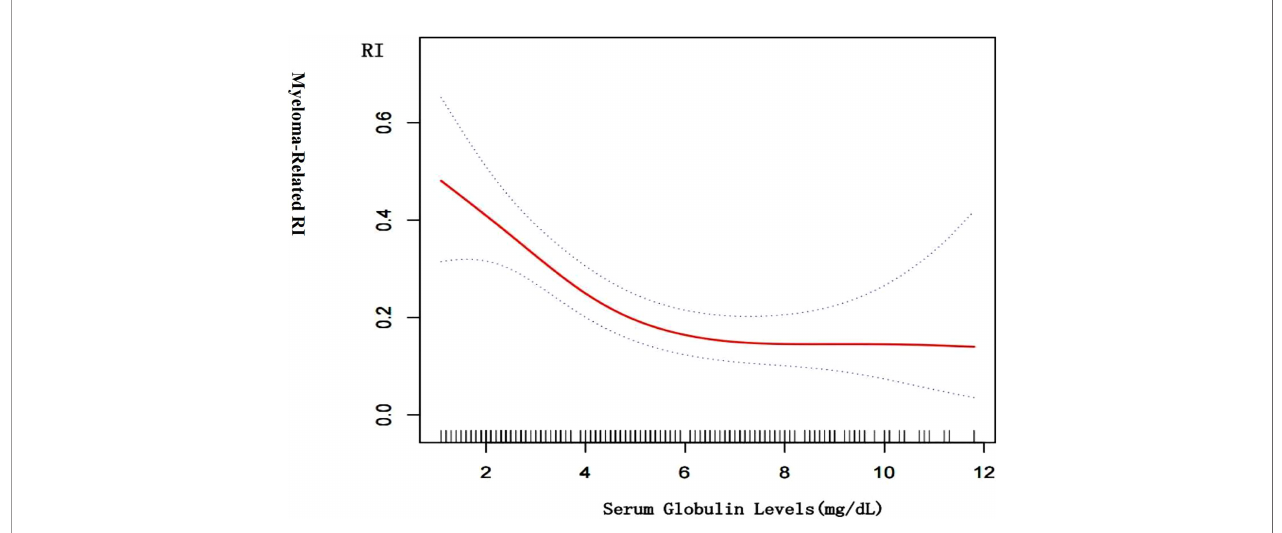
FIGURE 2 | Cross-sectional associations of serum globulin level with by using in a generalized additive model and smooth curve fi tting. There was a negative correlation between the serum globulin level and RI (p < 0.01) after adjusting for age; sex, LDH, urinary kappa/ Lambda light chain, serum kappa/Lambda light chain, HB, ISS-stage, serum albumin, serum beta 2 microglobulin.